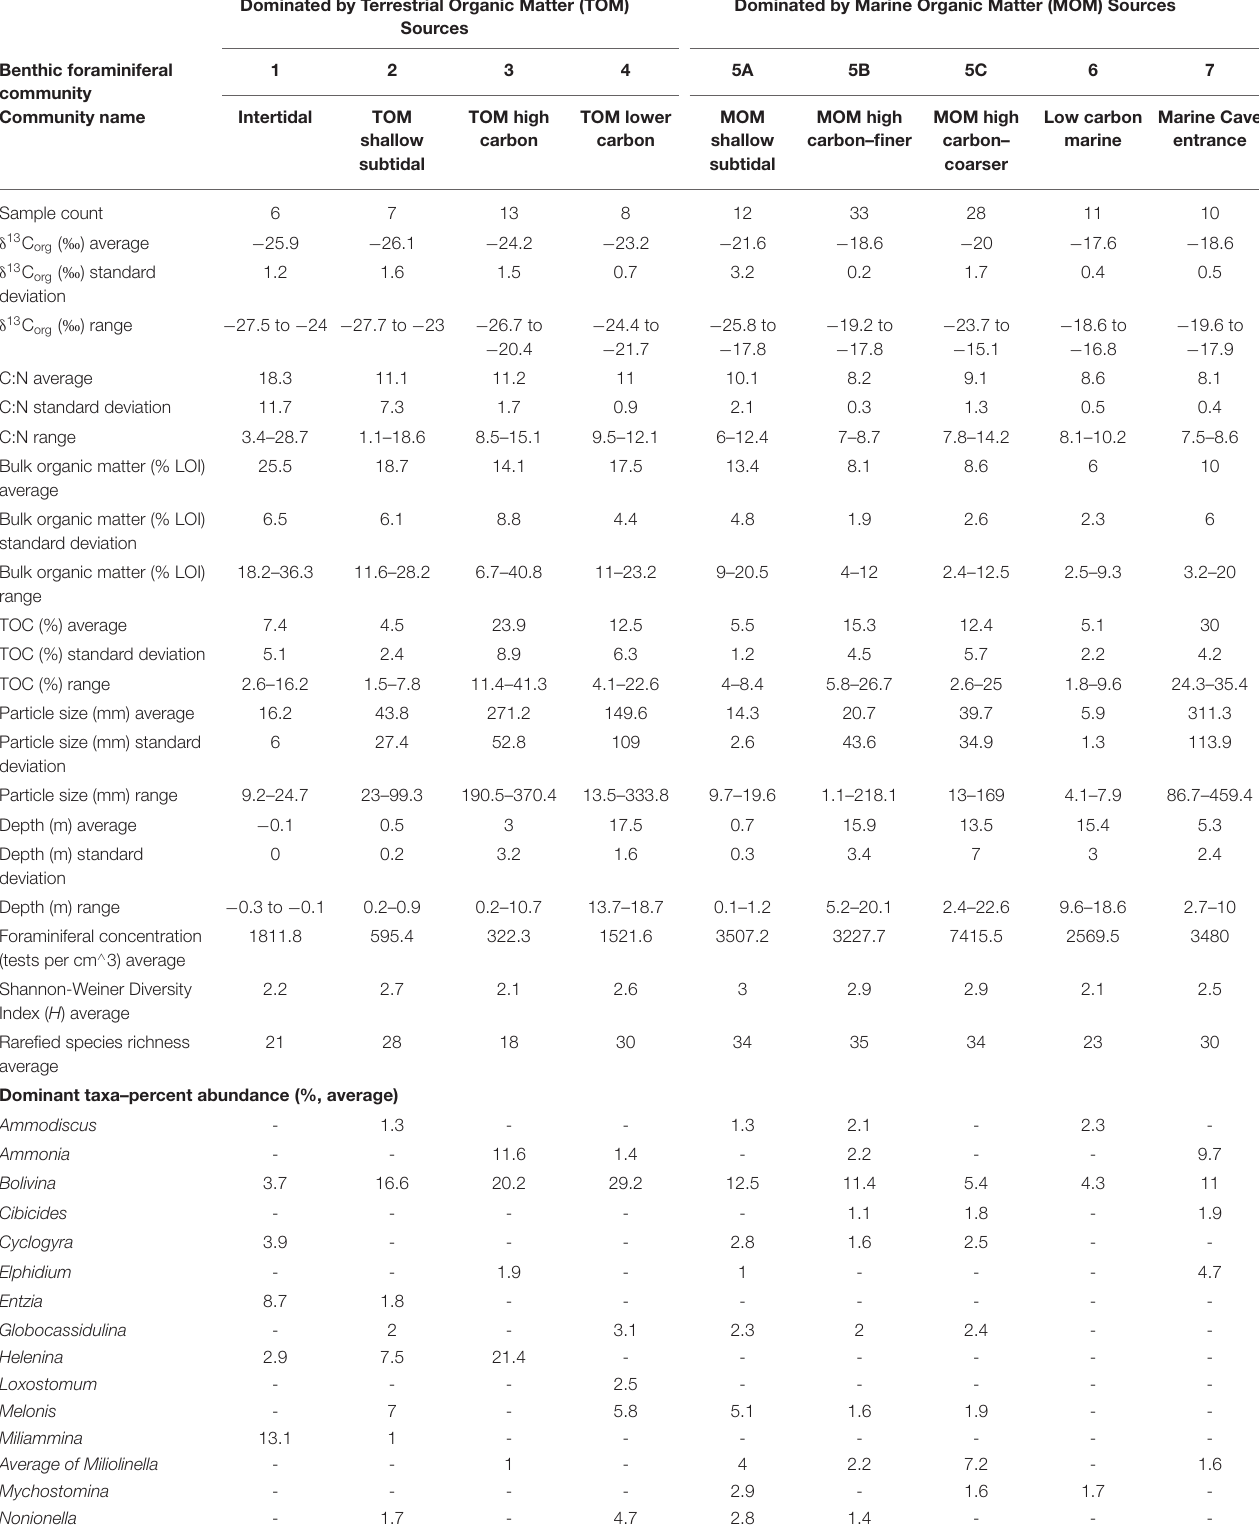
TABLE 1 | Selected summary statistics for environmental characteristics, and arithmetic mean of the percent abundance of dominant taxa in each benthic foraminiferal community. Dominated by Terrestrial Organic Matter (TOM) Dominated by Marine Organic Matter (MOM) Sources